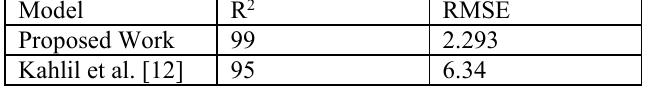
Table 4. Comparative Results